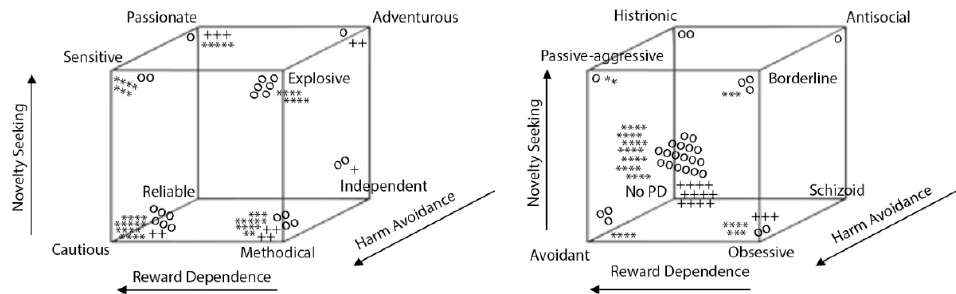
Figure 3. Temperamental profile and personality disorders in TCI-R for different groups of patients.